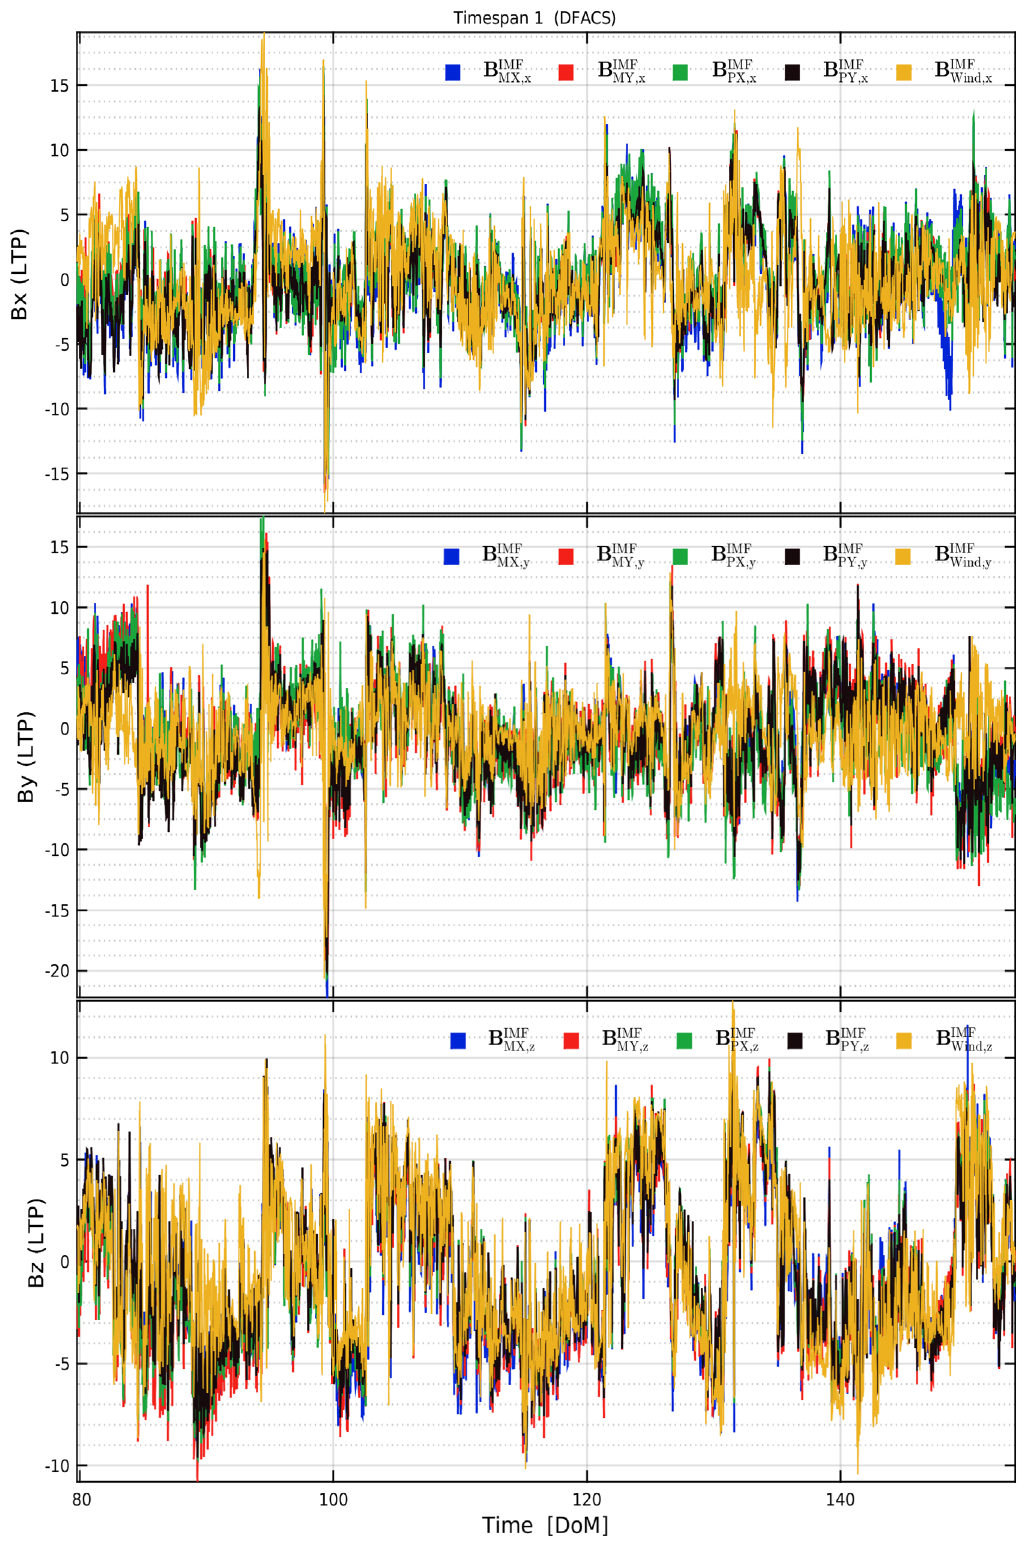
Figure 9. Estimated LPF IMF time-series ( B IMF time interval (see Table